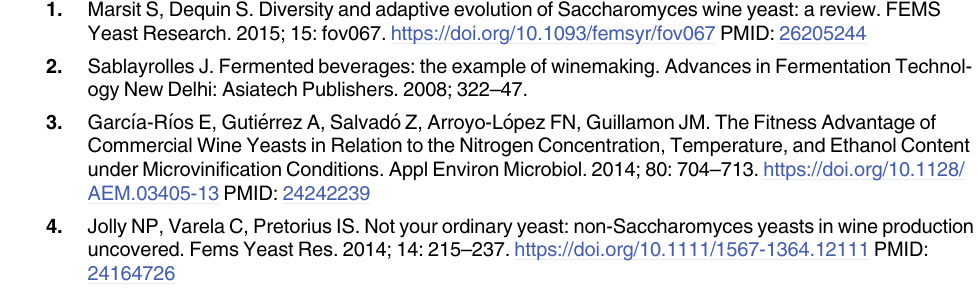
S1 Table. Growth parameter values for each type of